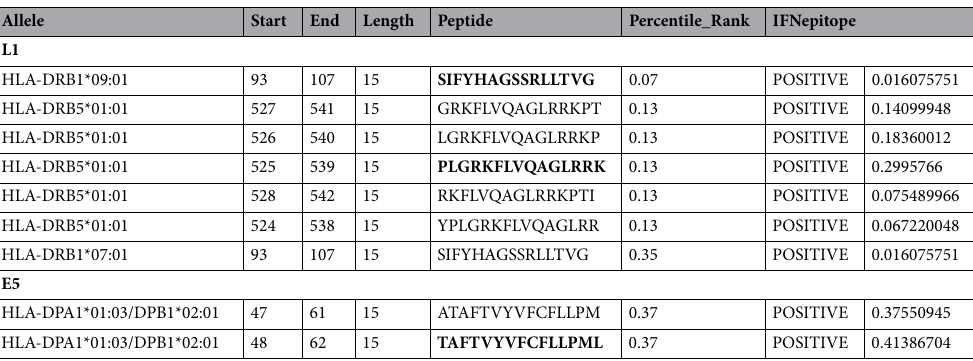
Table 4. MHC-II epitopes of L1 & E5 proteins of HPV 18. Bold text represents the peptides used in vaccine